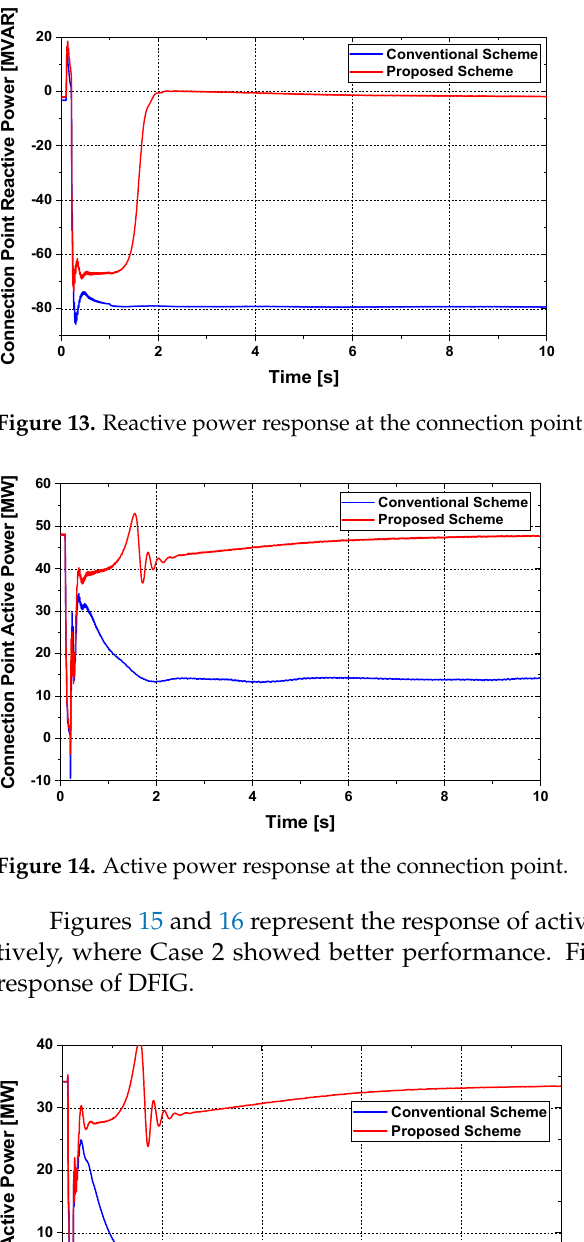
Figure 12. Rotor speed performance of SCIG. Figures 13 and 14 represent the reactive and active power response of the connection point. It was seen from both figures; the reactive and active powers were stable in Case 2.